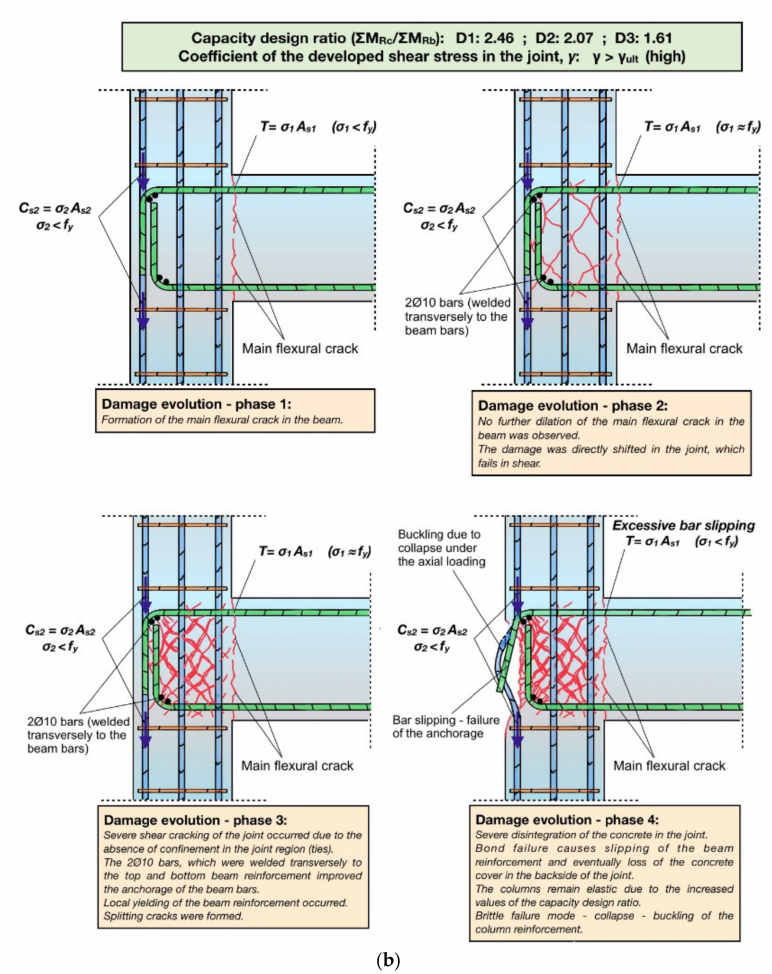
Figure 9. Evolution of damage for ( a ) subassemblages DCM _1, DCM _2, and DCM _3; ( b ) subassem- blages D 1, D 2, and D